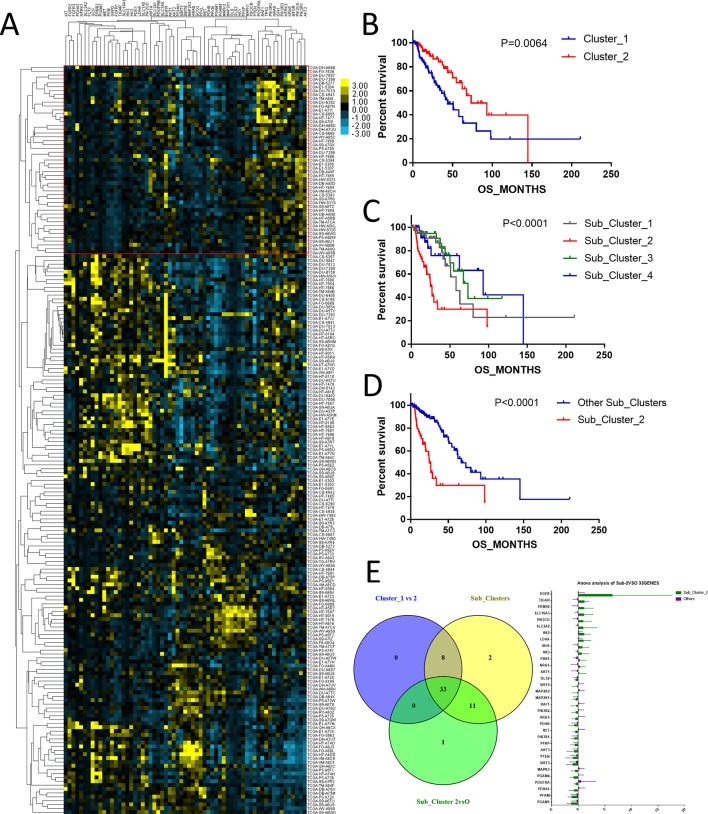
The expression profile of central carbon metabolism–associated genes in patients with astrocytoma. (A) According to expression profiling, two primary clusters and additionally four subdivided clusters were identified. The comparison of median survival between two primary clusters (B) and five subdivided clusters (C) showed significant difference. In addition, patients in subcluster 2 showed the worst prognosis comparing to other patients, P < 0.0001 (D). (E) Differential expression analysis demonstrated that 33 metabolism-associated genes were significantly variated in all contrast of clusters 1 and 2, subcluster 2 and the other subclusters, and five subclusters.